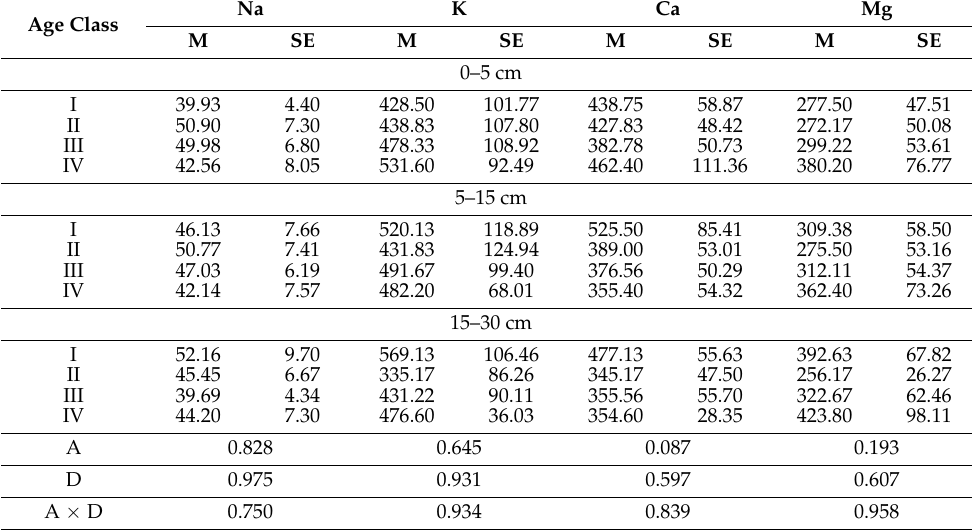
Table 2. Mean (M) with standard error (SE) concentrations (mg/kg of the soil) of the macroelements in the three top layers of the soil (0–5, 5–15 and 15–30 cm) under silver birch regeneration by age class (I, II, III and IV—1–4, 5–8, 9–12 and 13–17 years,